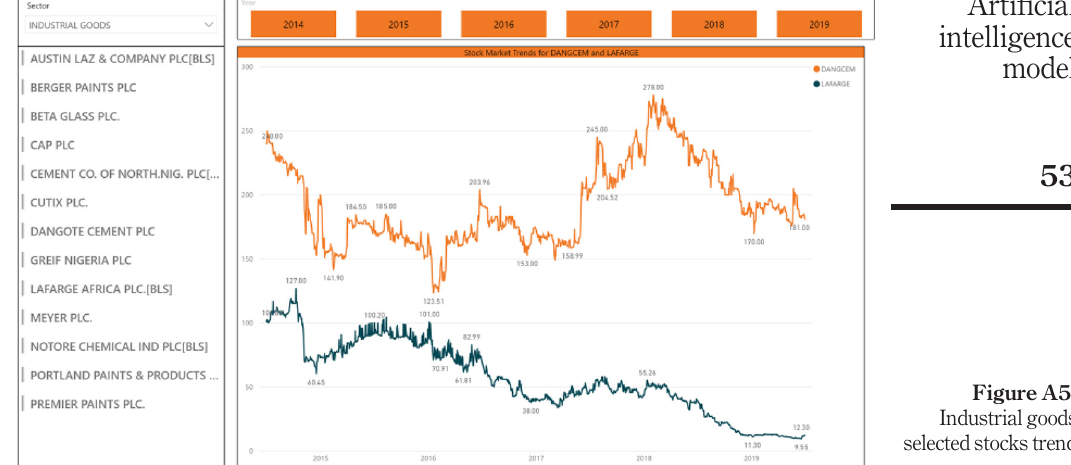
Figure A5. Industrial goods selected stocks